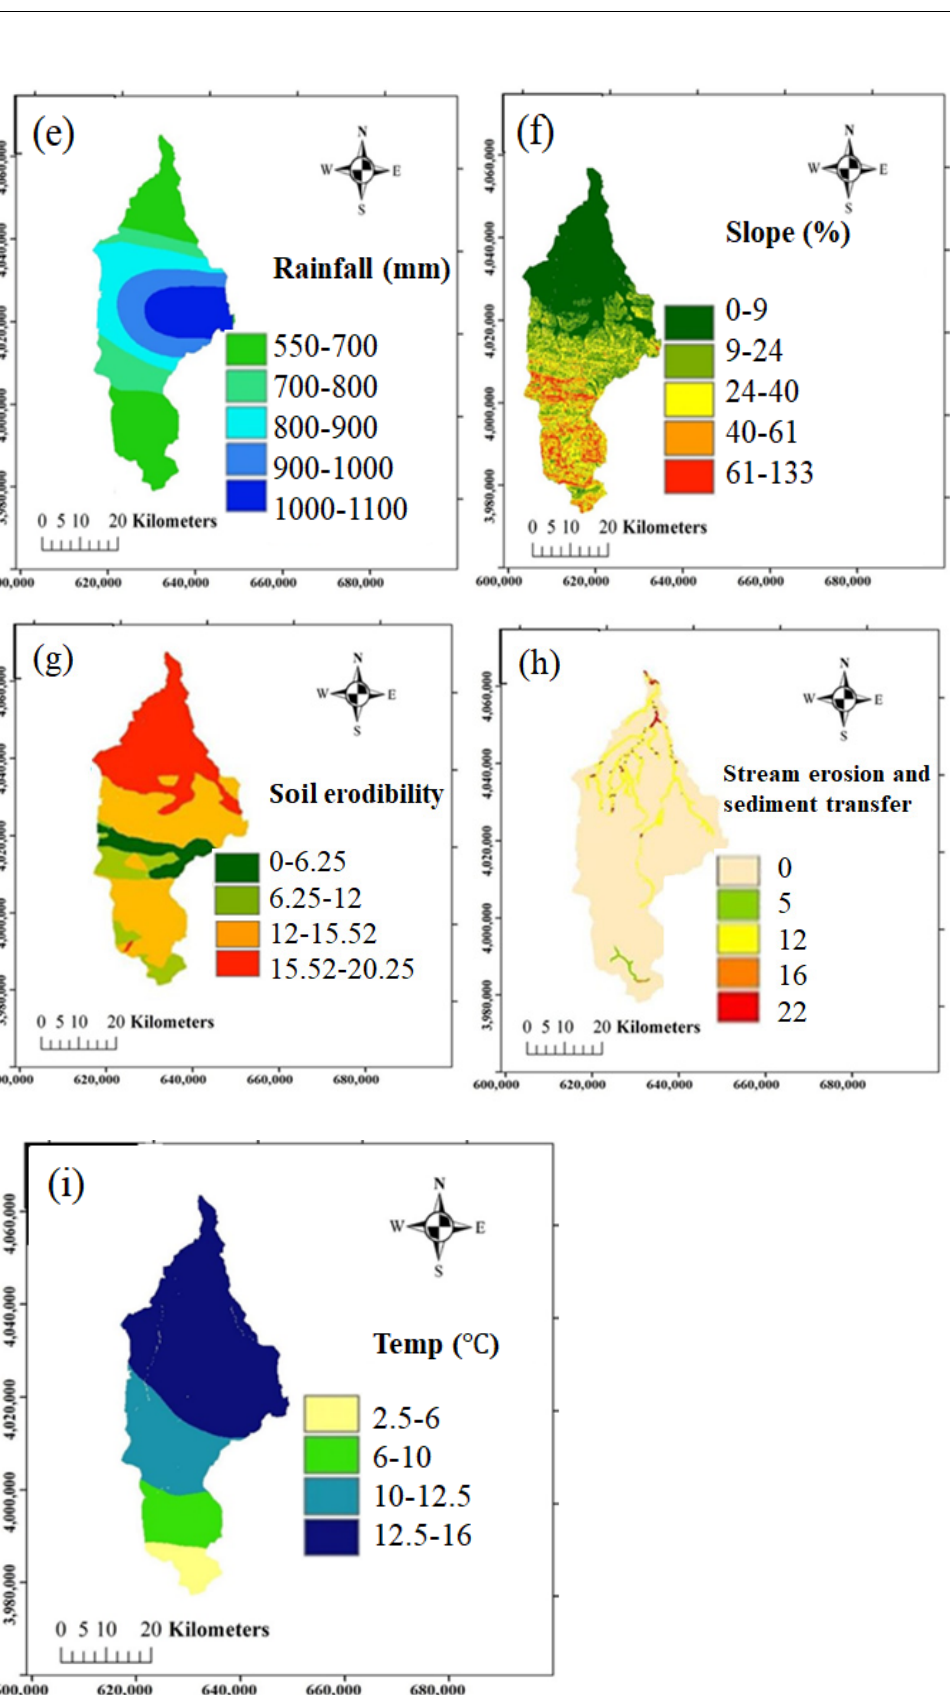
Figure 2. Maps of the study watershed: ( a ) digital elevation model; ( b ) geology; ( c ) soil map; ( d ) land use; ( e ) annual precipitation (mm) ( f ) slope; ( g ) upland erosion; ( h ) channel erosion; ( i ) temperature.